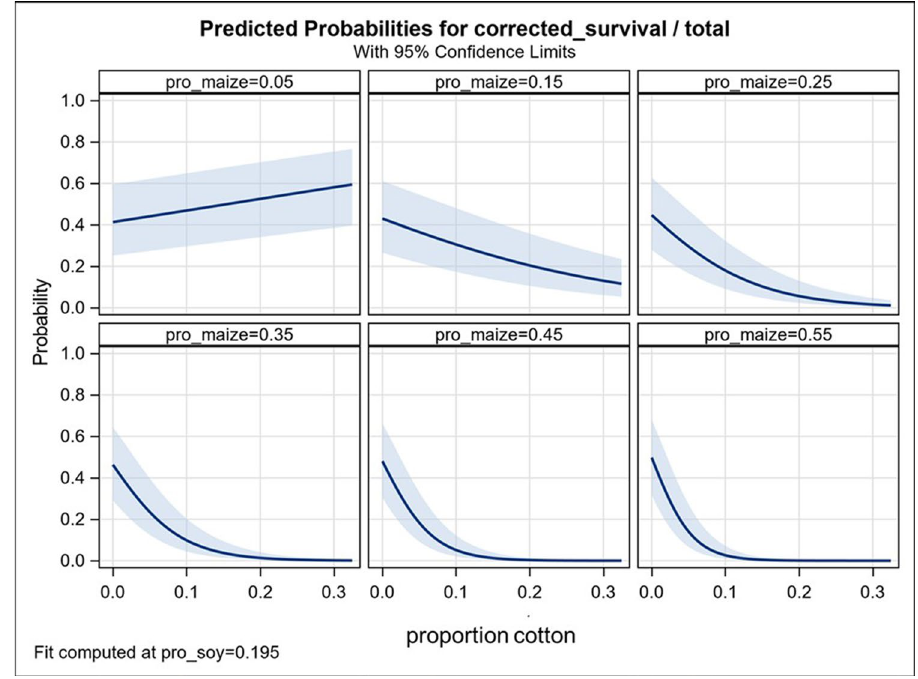
Figure 3. Predicted survival of H. zea larvae in response to proportional areas of cotton at six levels of proportional abundance of maize during the prior year within a 1-km radius of the collection site. Proportional abundances of maize shown (0.05; 0.15; 0.25; 0.35; 0.45; 0.55). were selected to illustrate changes in response to maize abundance across the range observed in our study (0.01 to 0.54). Data provided in Table S2. Fit is computed at the mean proportional area of soybean (0.195). Shaded bands are